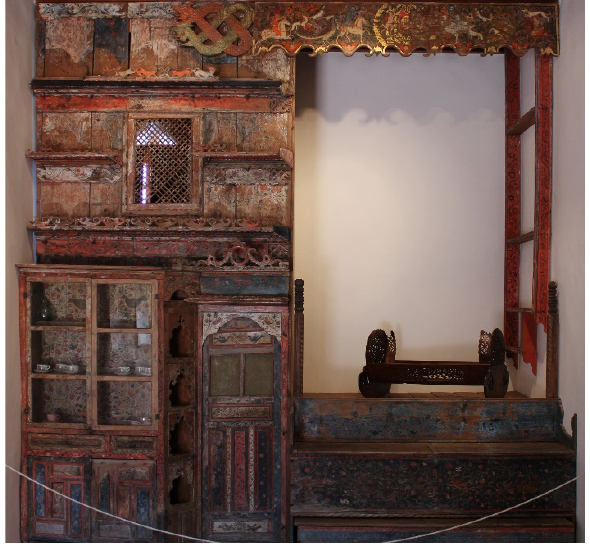
Figure 7. Nikolaidis’ house-museum